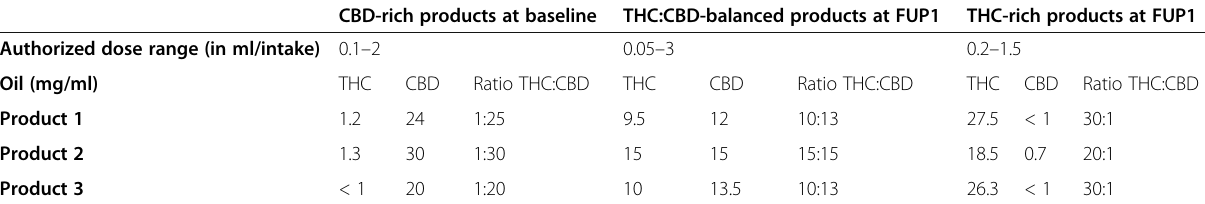
Table 1 THC and CBD contents and associated THC:CBD ratio for the three most common oil products authorized at the clinic CBD-rich products at